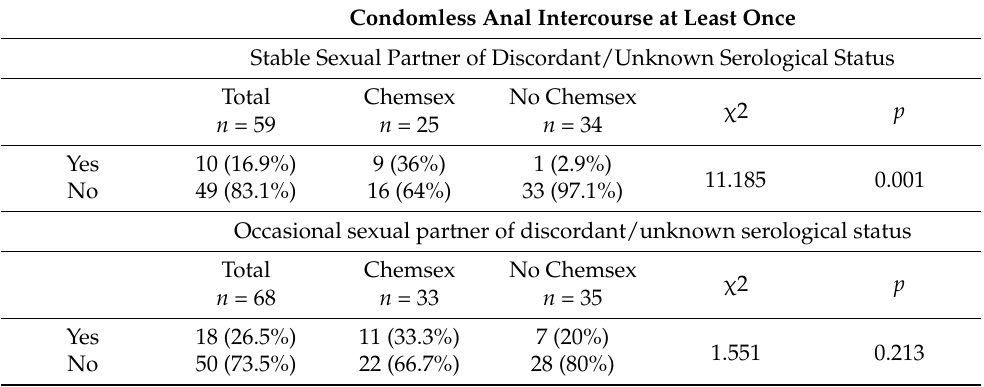
Table 5. Condomless anal intercourse at least once with stable and occasional sexual partners of discordant/unknown serological status.